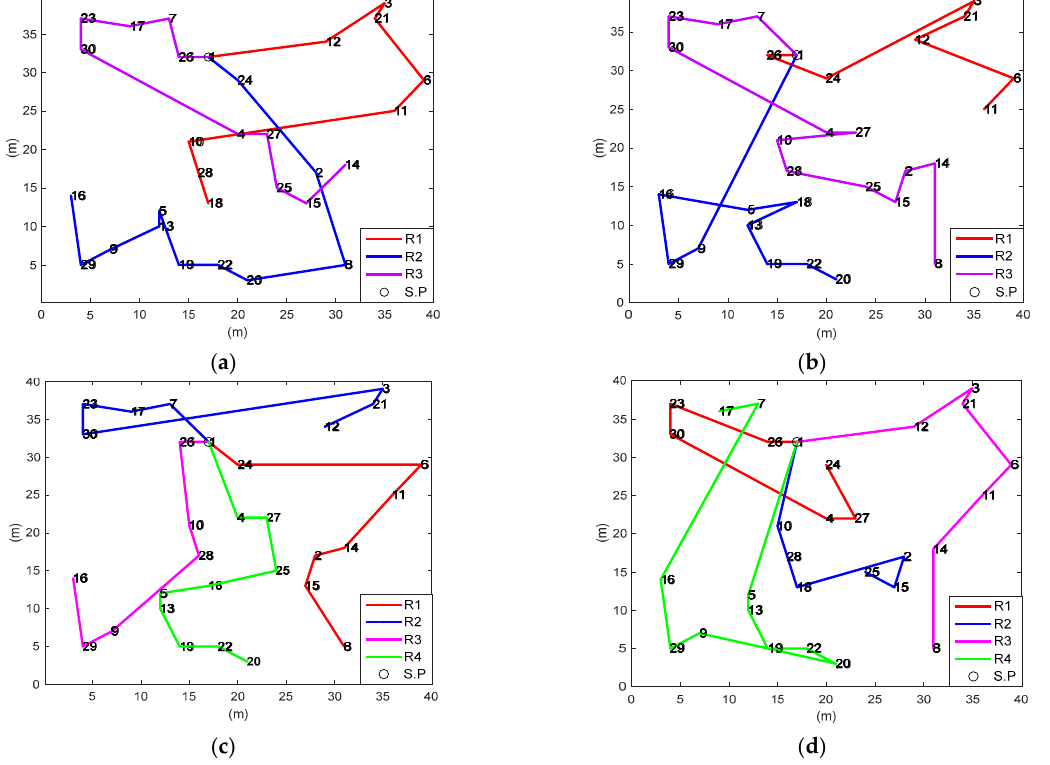
Figure 9. Multirobot optimal task allocation diagram from Experiment 1: ( a ) algorithm in this paper ( m = 30, n = 3); ( b ) basic genetic algorithm ( m = 30, n = 3); ( c ) algorithm in this paper ( m = 30, n = 4); ( d ) basic genetic algorithm ( m = 30, n = 4).